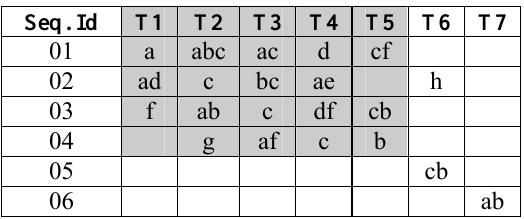
Table 1. Sample Database